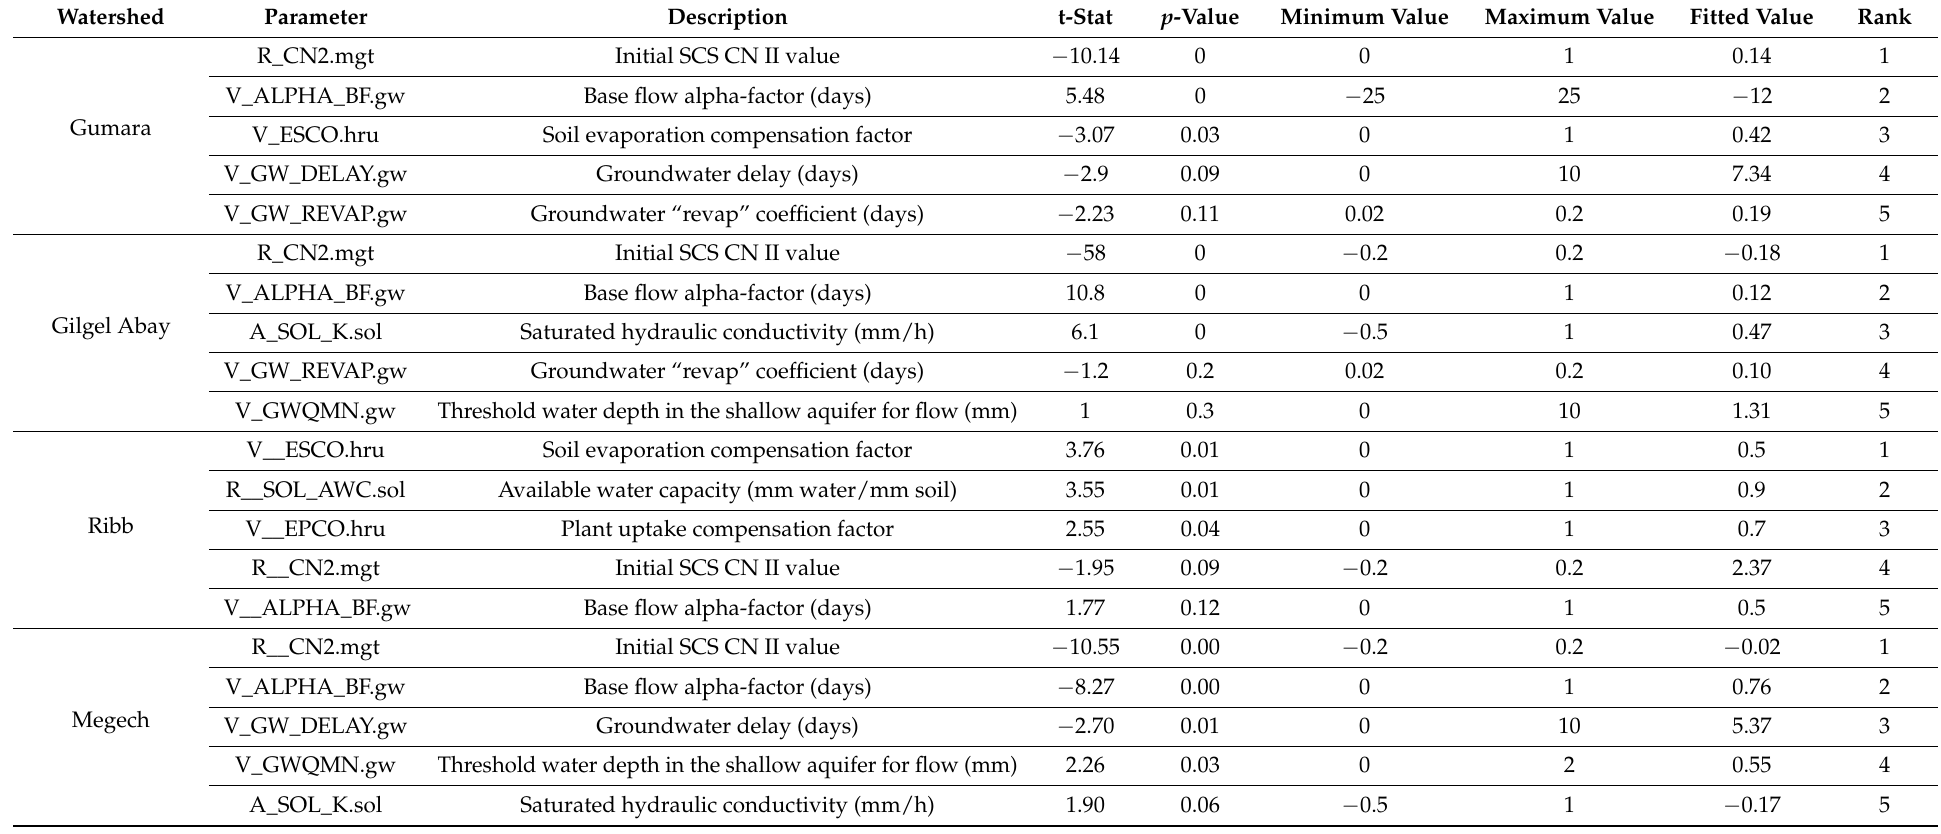
Table 4. Hydrological parameters used in SWAT